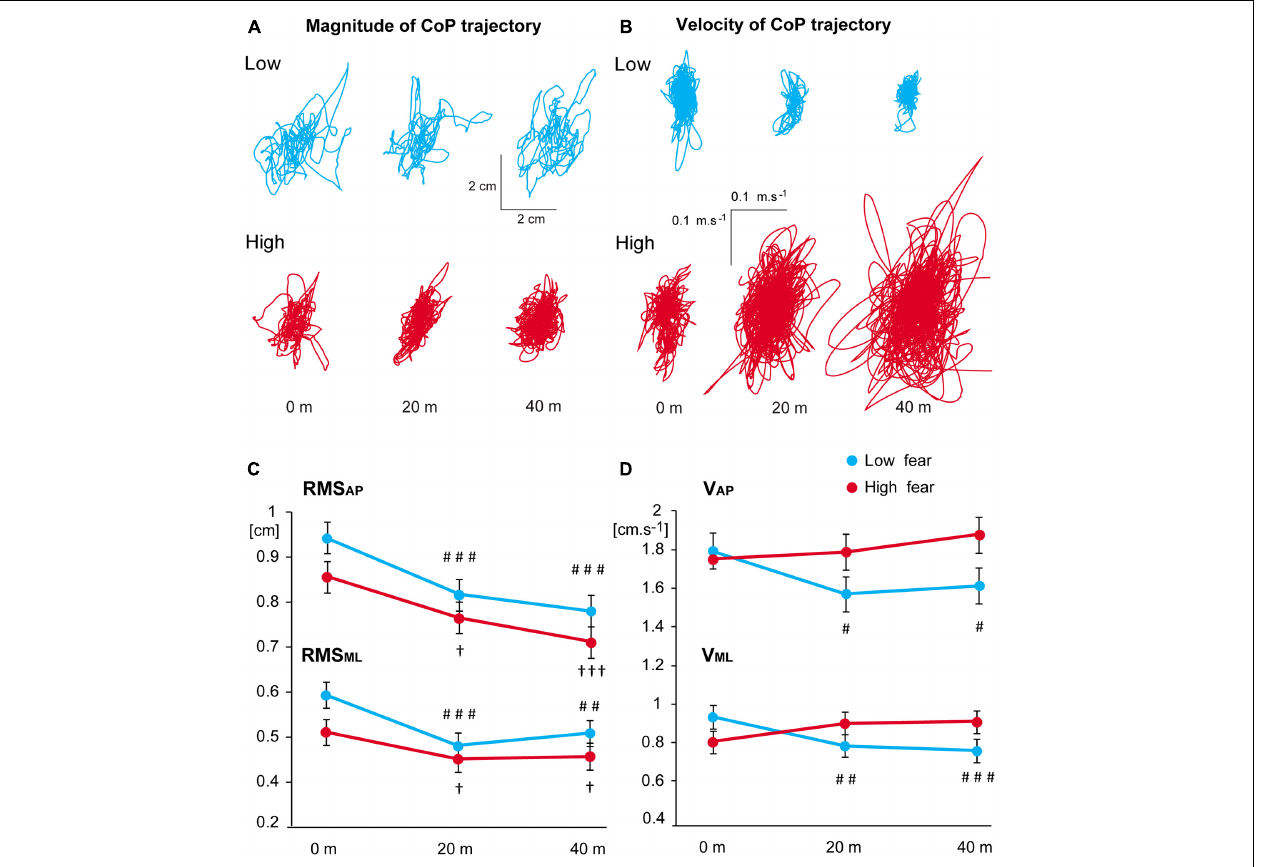
FIGURE 3 | (A,B) Representative examples of individual trajectories in participants in the low and high fear groups during exposure to virtual height: (A) magnitude of the CoP displacement, (B) velocity of the CoP displacement. (C,D) Estimated marginal means ± SEM of the RMS (C) and velocity (D) of CoP deviations in both directions in 0, 20, and 40 m virtual heights in the low and high fear groups. Significant differences between heights 0 versus 20 m and 0 versus 40 m are marked as follows: # p < 0.05, ## p < 0.01, ### p < 0.001 for the low fear group and † p < 0.05, ††† p < 0.001 for the high fear